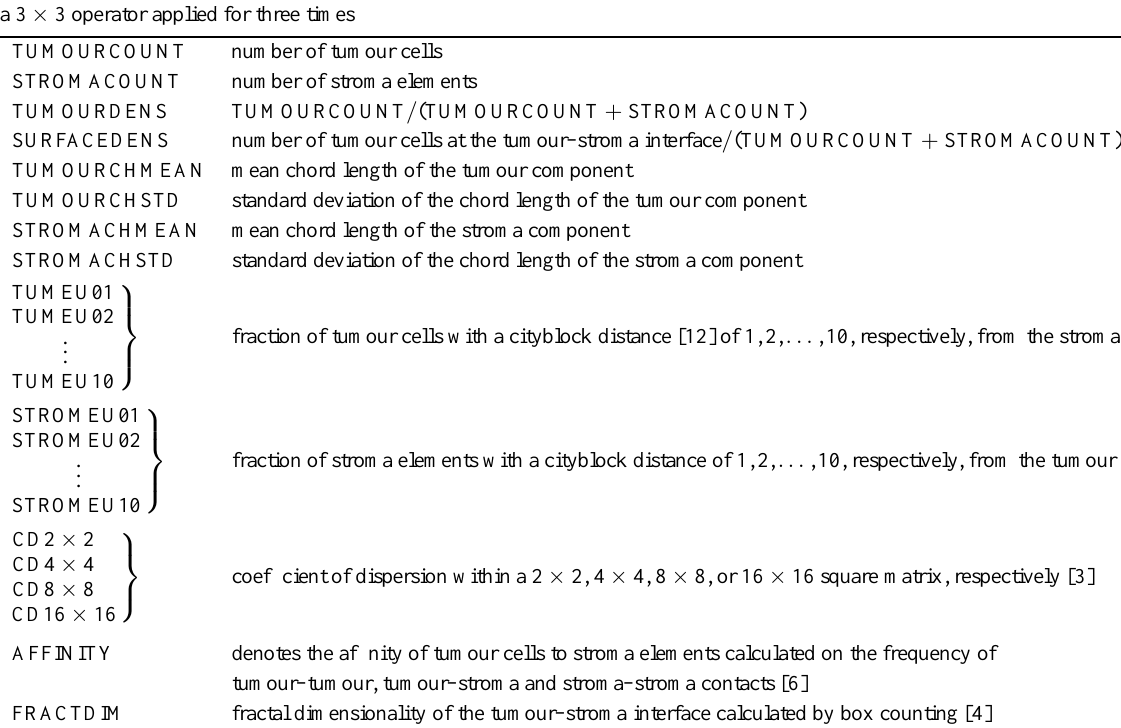
Pattern interpretation in simulated tumour patterns using cellular automata. Acronyms and definition of pattern measurement features. All measurements are carried out within the “area of interest” defined by a closing operation of the tumour cells